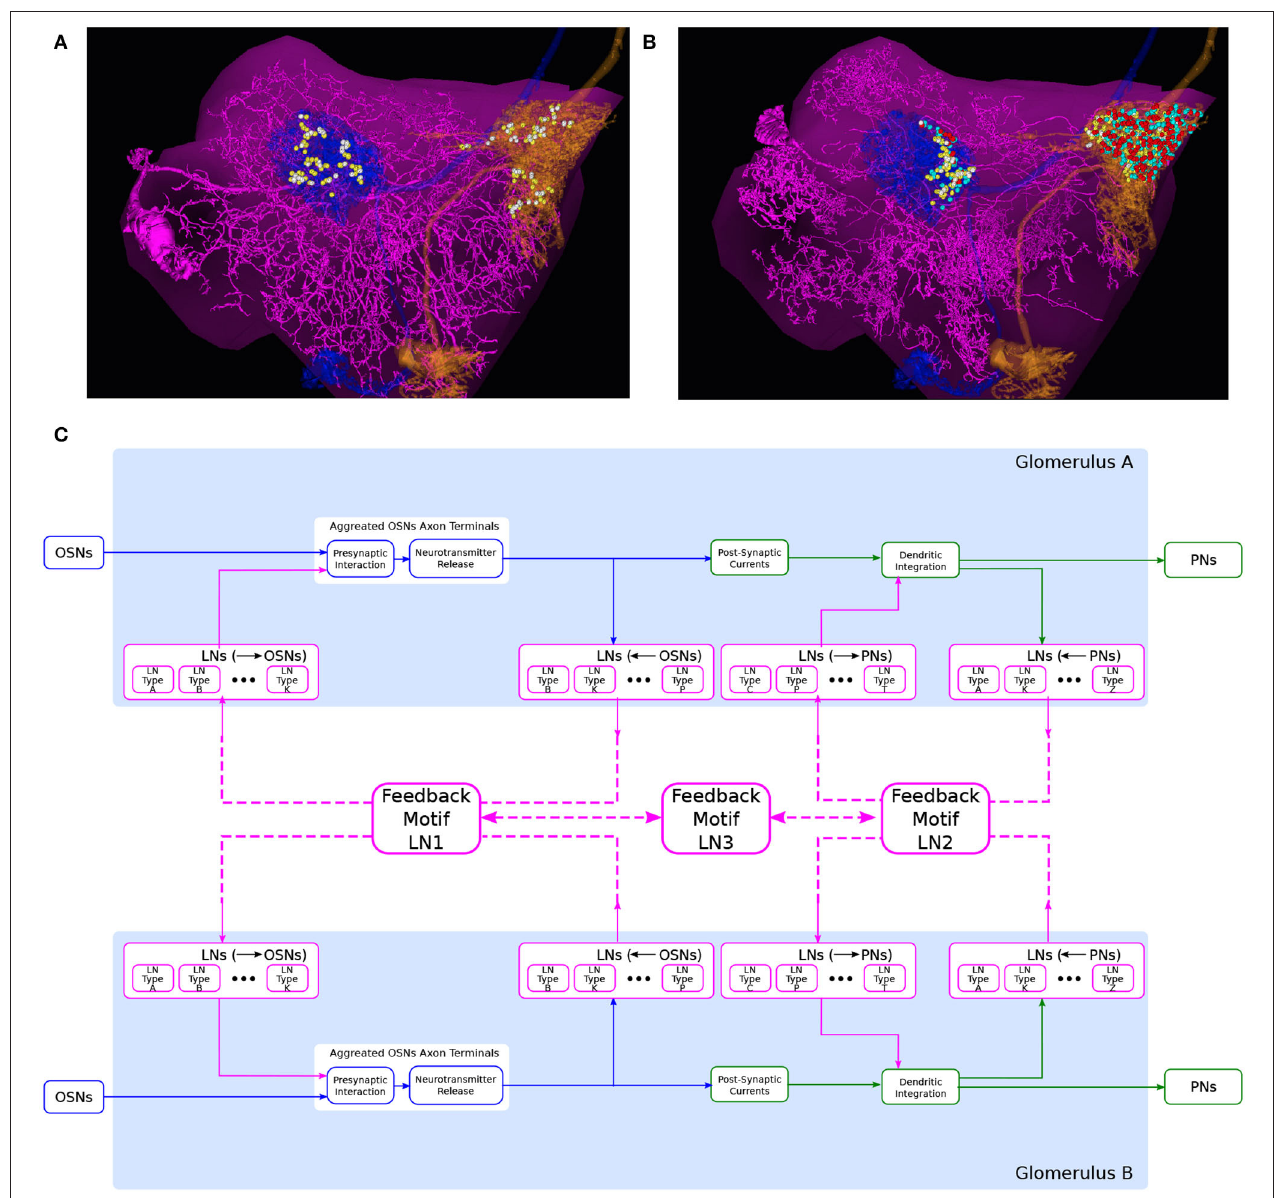
FIGURE 8 | An abstraction of glomerular feedback circuits with 3 feedback motifs. (A) An LN that is presynaptic and postsynaptic to the PNs, but not to OSNs, in both DL5 and DM4 glomeruli. (magenta) the LN, (blue) a PN with dendrites arborizing the DL5 glomerulus, (orange) a PN with dendrites arborizing DM4 glomerulus, (yellow dots) locations of PN-to-LN synapses, (white dots) locations of LN-to-PN synapses. (B) An LN that is presynaptic and postsynaptic to the OSNs and PNs in both DL5 and DM4 glomeruli. Color is the same as in (A) and additionally, (cyan dots) locations of OSN-to-LN synapses, (red dots) locations of LN-to-OSN synapses. (C) A circuit diagram of two glomeruli with 3 feedback motifs. Feedback motif LN1 corresponds to the port connectivity patterns 1100 of each of the two glomeruli. Feedback motif LN2 corresponds to the port connectivity patterns 0011 of each of the two glomeruli, e.g., (A) . Feedback motif LN3 models the bidirectional connectivity between LN1 and